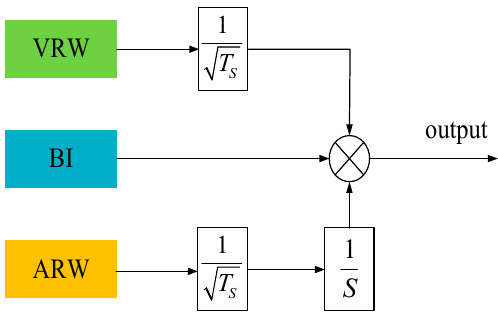
Figure 1. MSRA random error model ( T S is the sampling time).